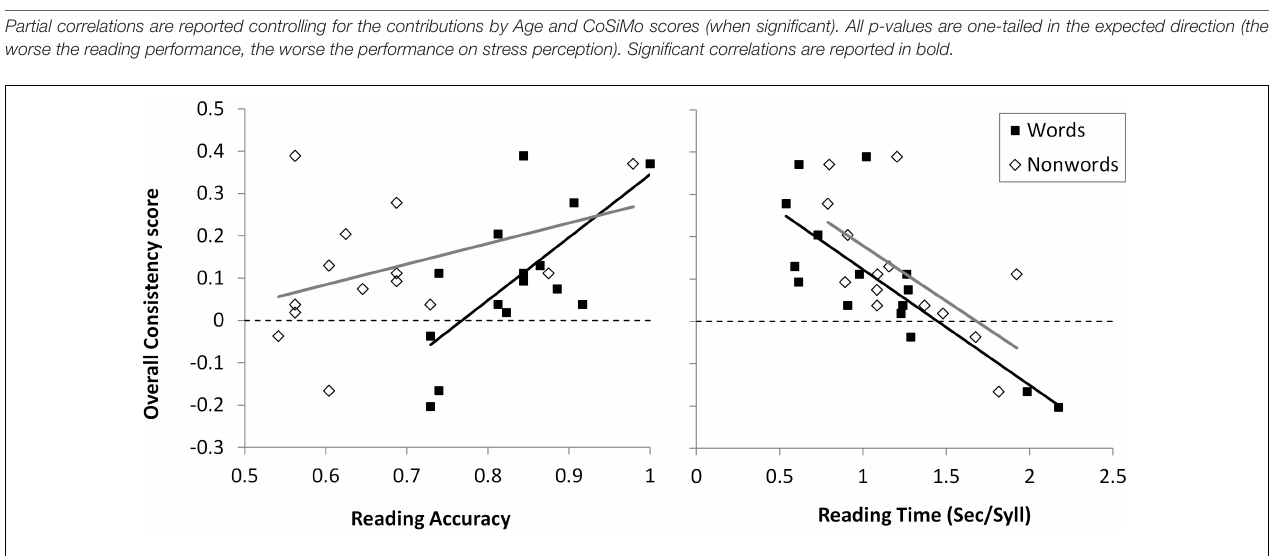
FIGURE 6 | Overall Consistency scores on the Stress Perception task (vertical axes) are plotted against Reading Accuracy (proportion correct, left panel ) and Reading Time (seconds per syllable, right panel ) on the DDE task, for children with Developmental Dyslexia. Dashed horizontal lines report chance level (OC = 0); solid black lines are the regressions for words (filled squares); solid gray lines are the regressions for non-words (open